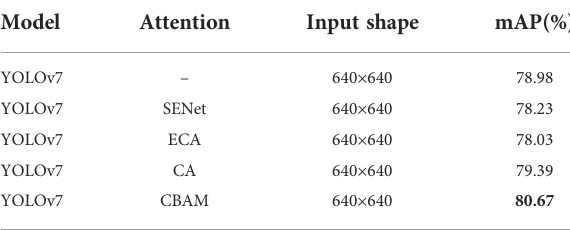
TABLE 2 mAP measurements for different attention